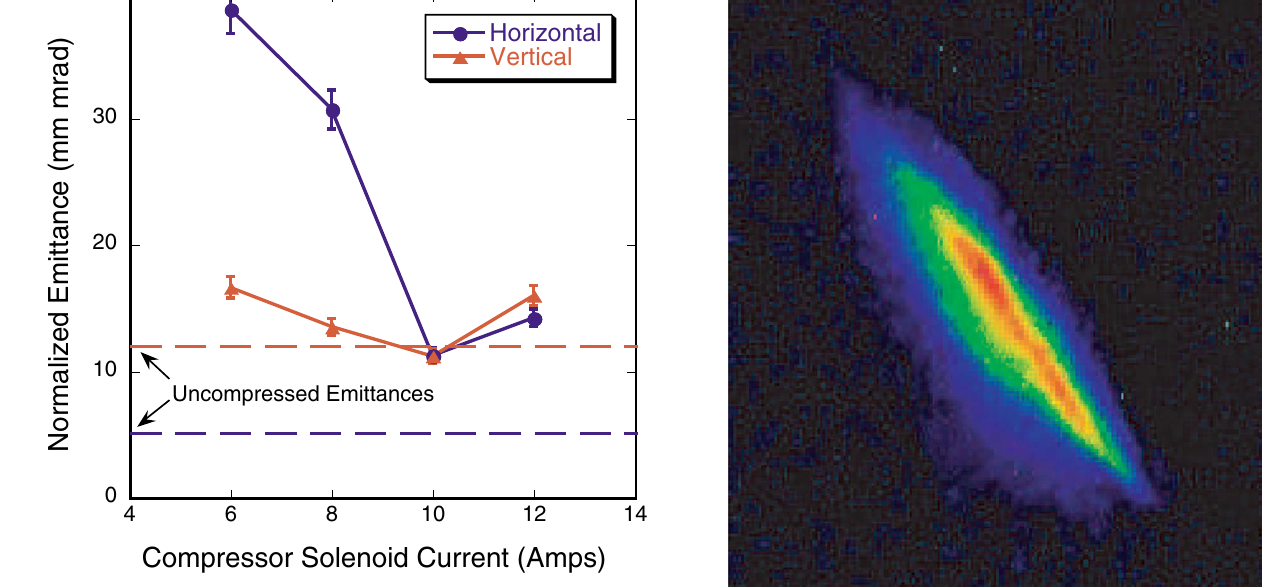
FIG. 27. (Color) False-color image of the electron beam show- ing a strong x - y correlation.